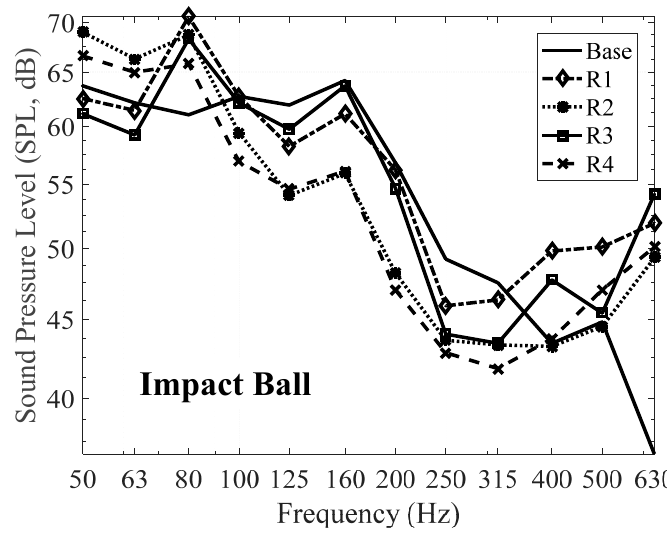
Figure 15. Floor impact sound level with the proposed materials in 1/3 Octave bands—Impact ball. Materials 2016 , 9 , 592